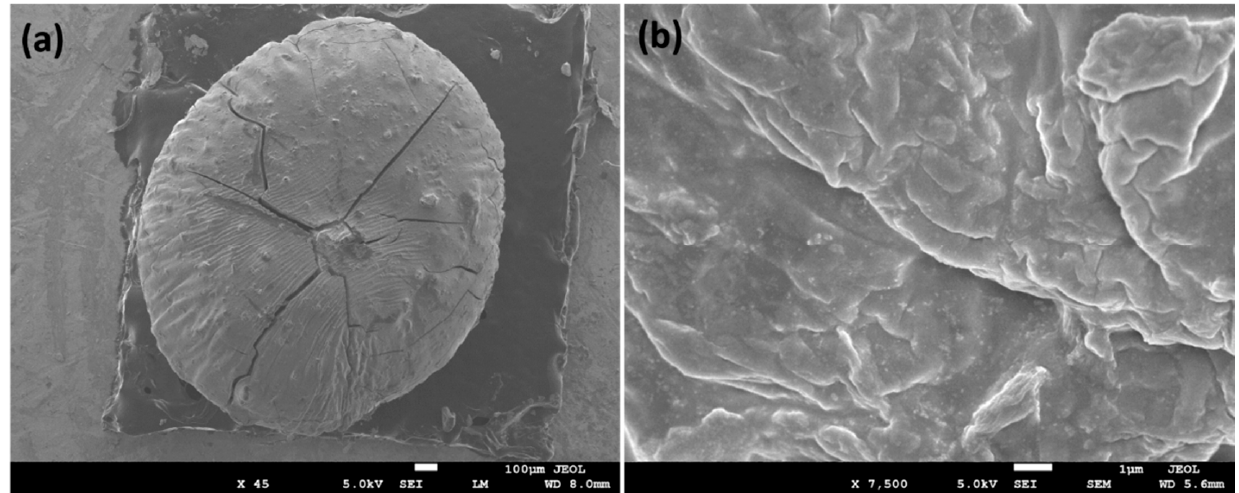
Figure 1. FESEM images of Cu@Alg/BP nanocatalyst at ( a ) low and ( b ) high magnifications.